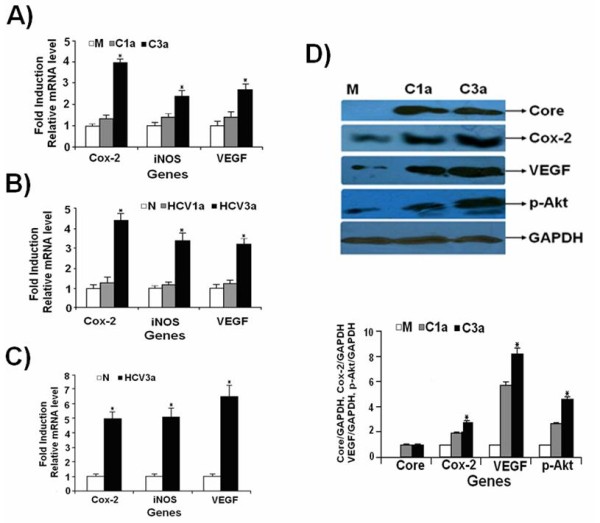
HCV 3a Core gene shows higher induction of Cox-2, iNOS, VEGF and p-Akt compared to HCV 1a Core gene. (A) Comparison of gene expression of Cox-2, iNOS and VEGF in Huh-7 cells transiently transfected with HCV Core 1a (C1a), 3a (C3a) and pCR3.1 plasmid alone as mock (M) samples (0.4 μg DNA/well of each plasmid). After 48 hrs incubation, relative gene expression levels were determined. (B) Comparison of expression of Cox-2, iNOS, and VEGF genes expressed as relative fold induction in HCV 1a and 3a infected patient's blood samples verses normal. (C) Expression of Cox-2, iNOS and VEGF genes in HCV 3a genotype infected liver biopsies verses normal. (D) The protein expression levels were determined by Western blot analysis of Huh-7 cell lysates transfected with HCV Core vectors 1a, 3a and effect on Cox-2, VEGF, p-Akt and GAPDH using specific antibodies. Blots were also normalized by measuring the amount of GAPDH (histogram). Bars are mean of optical density ratio of each group.* p < 0.001 verses control and Core 1a. GAPDH gene was used as internal control for normalization in Real-Time PCR and in Western blotting. All experiments were performed in 3 independent experiments having triplicate samples in each.